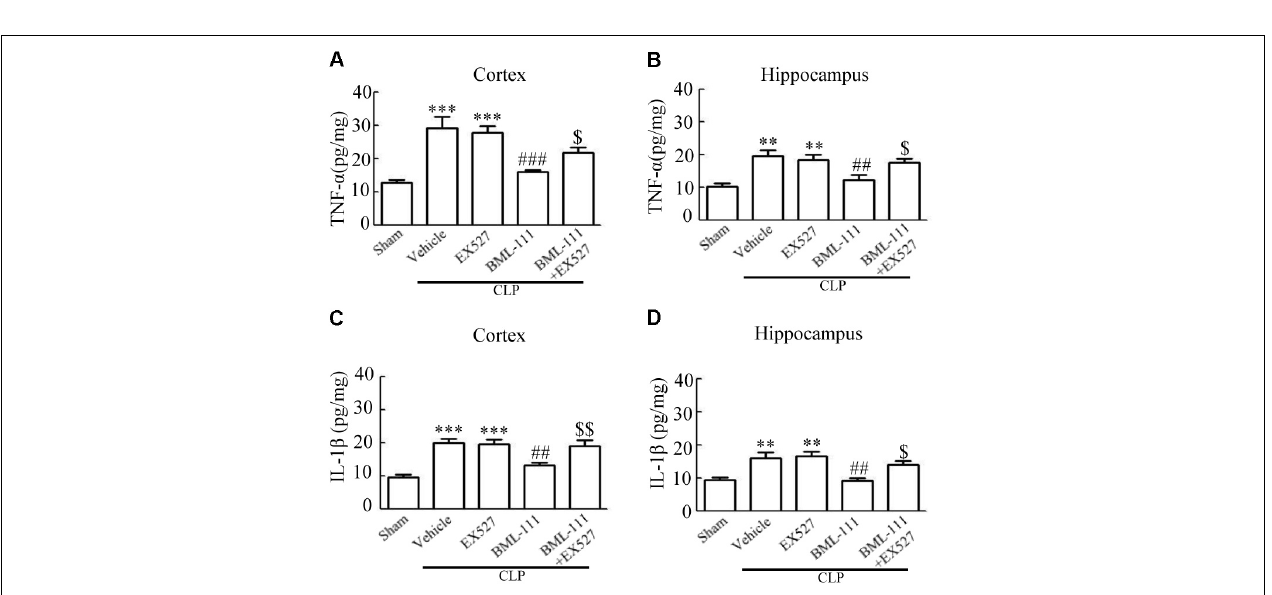
FIGURE 10 | BML-111 inhibits the expression of inflammatory cytokines via SIRT1 in CLP mice. The expression levels of TNF- α and IL-1 β were increased significantly in CLP + Vehicle and CLP + EX527 group when compared with sham group in cortex and hippocampus, and there was no difference in CLP + Vehicle group and CLP + EX527 group. BML-111 significantly decreased the levels of TNF- α and IL-1 β compared with CLP + Vehicle group. EX527 up-regulated the expression of inflammatory cytokines in the cortex and hippocampus when compared with the CLP + BML-111 group. Data were shown as the means ± SEM ( n = 5 surviving mice in A–C , n = 4 surviving mice in D ). ∗∗ P < 0.01, ∗∗∗ P < 0.001 represent CLP + Vehicle vs. Sham and CLP + EX527 vs. sham, ## P < 0.01, ### P < 0.001 represent CLP + BML-111 vs. CLP + Vehicle, $ P < 0.05, $$ P < 0.01 represent CLP + BML-111 + EX527 vs. CLP +